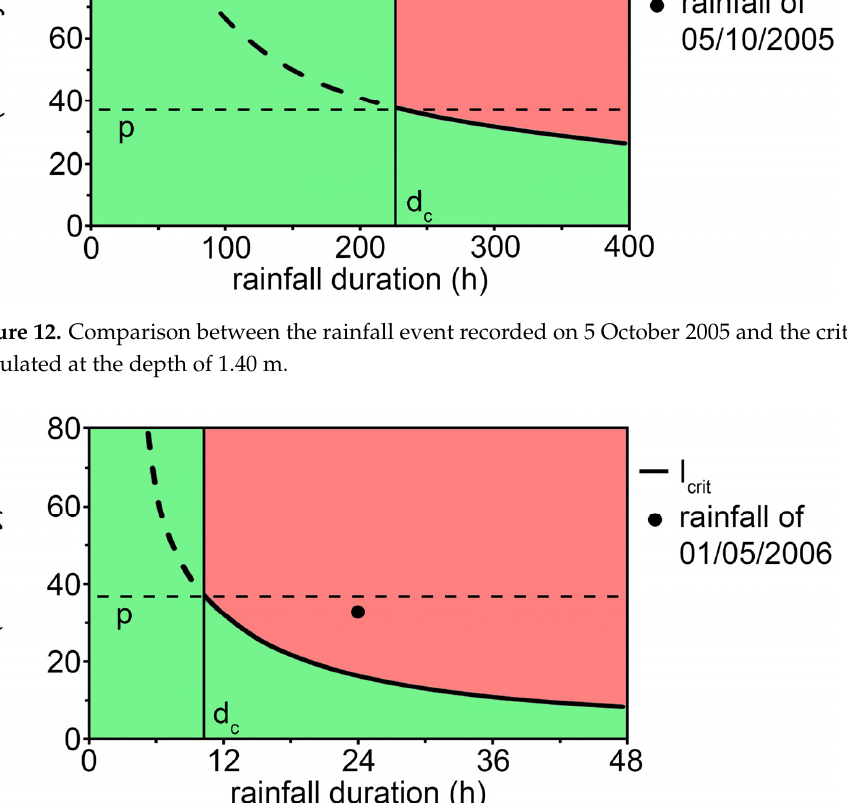
Figure 13. Comparison between the rainfall event recorded on 1 May 2006 and the critical curve calculated at the depth of 1.40 m.